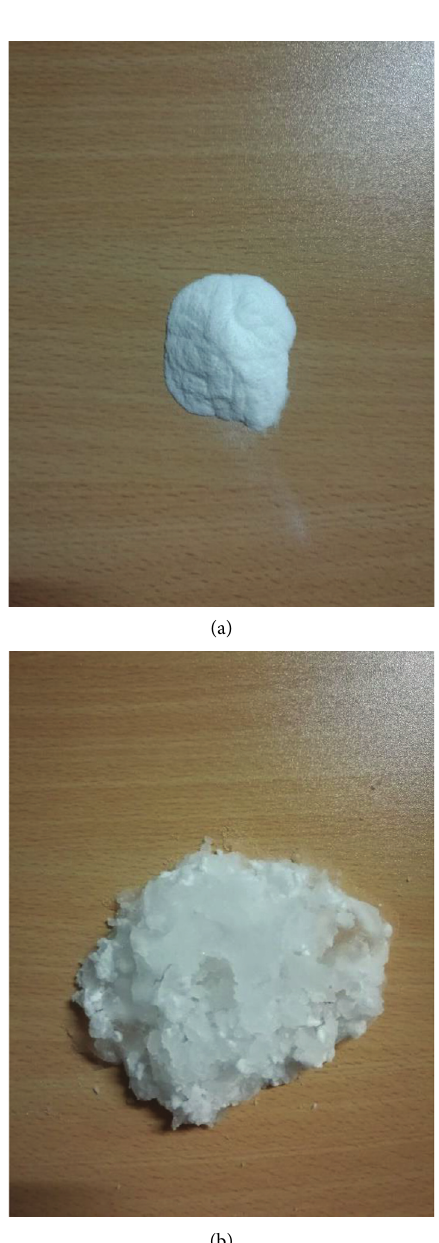
Figure 1: Superabsorbent polymer (SAP): collapsed (a); swollen (b).